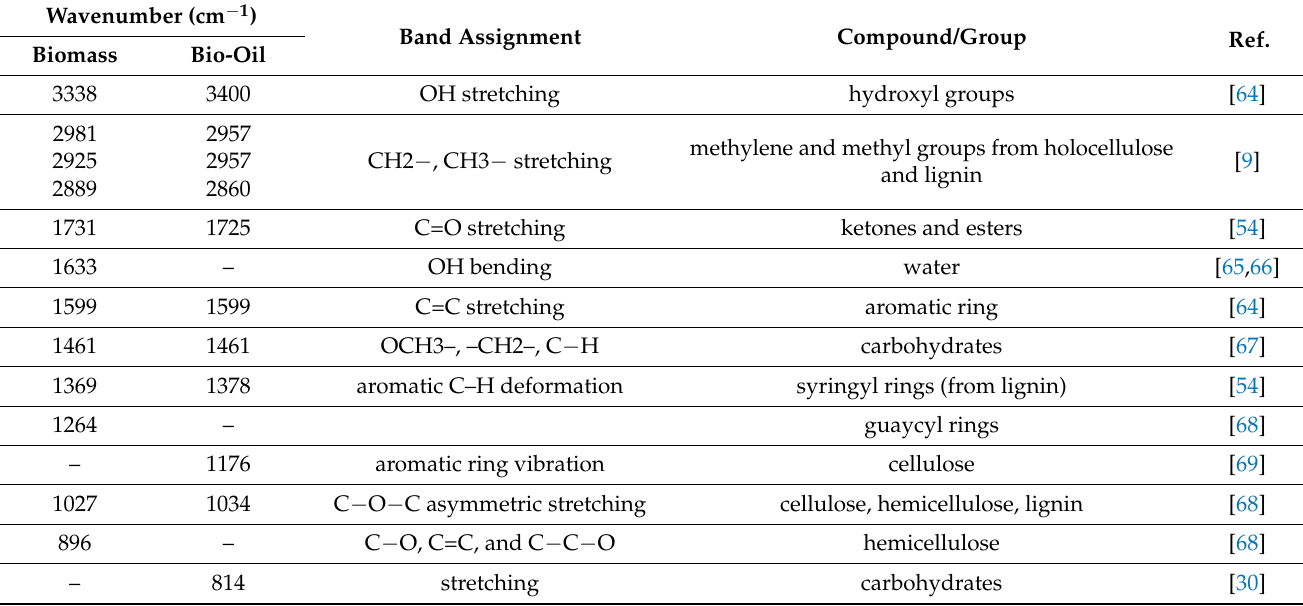
Table 2. ATR-FTIR band assignment (characteristic bands) for the bio-oils and biomass